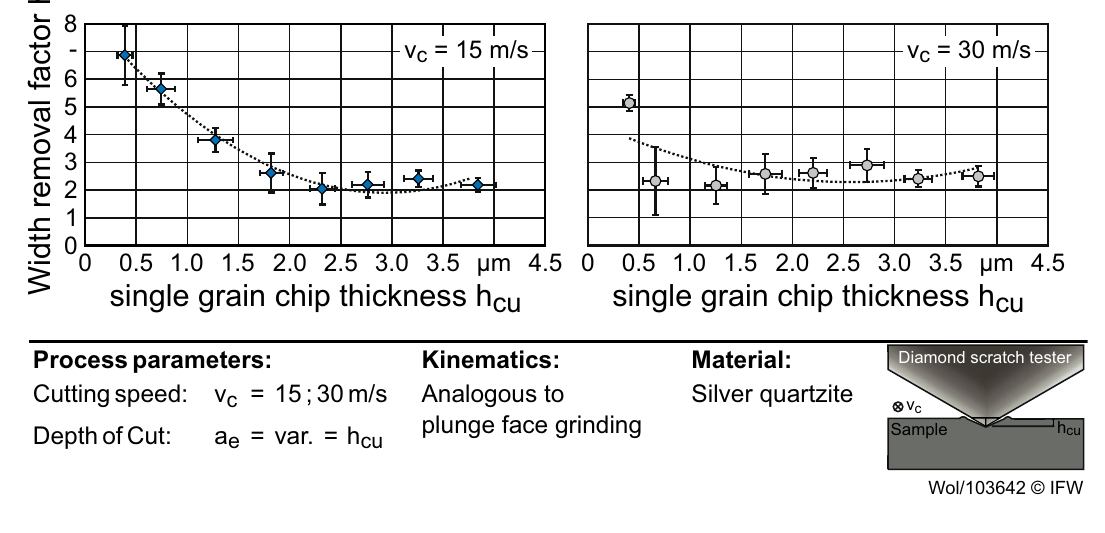
Fig. 7 Influence of cutting speed on width removal factor for Silver